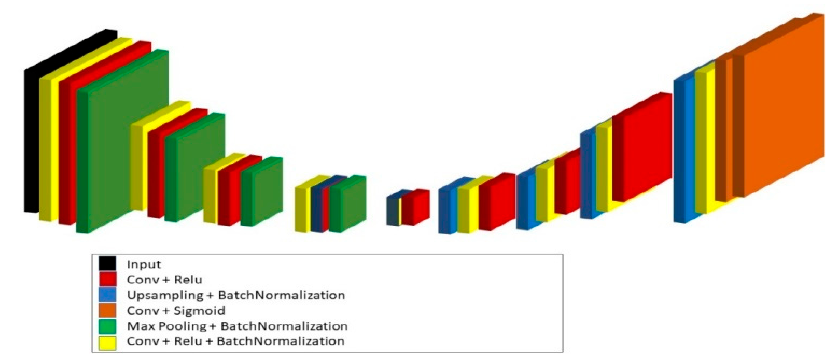
Figure 3. Illustration of implemented U-Net3 architecture.